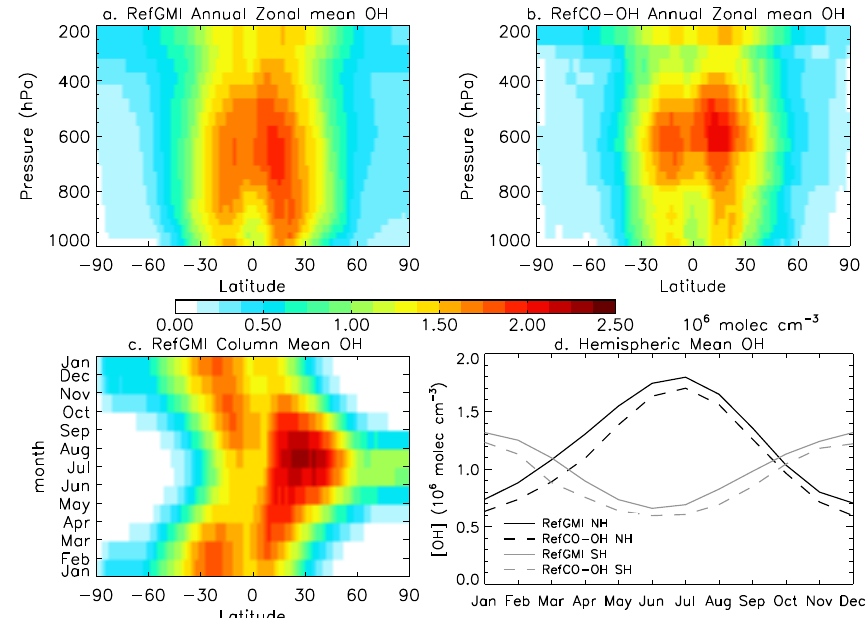
Figure 1. Simulated annual zonal mean OH concentration for the RefGMI (a) and RefCO–OH simulations (b) averaged over 1999–2009. (c) The annual cycle of the pressure-weighted column mean OH by latitude from the RefGMI simulation. The column is averaged between the surface and 200hPa. (d) The annual cycle of hemispheric mean OH from the RefGMI (solid lines) and RefCO–OH (dashed lines) simulations for the Northern Hemisphere (black lines) and Southern Hemisphere (gray lines).